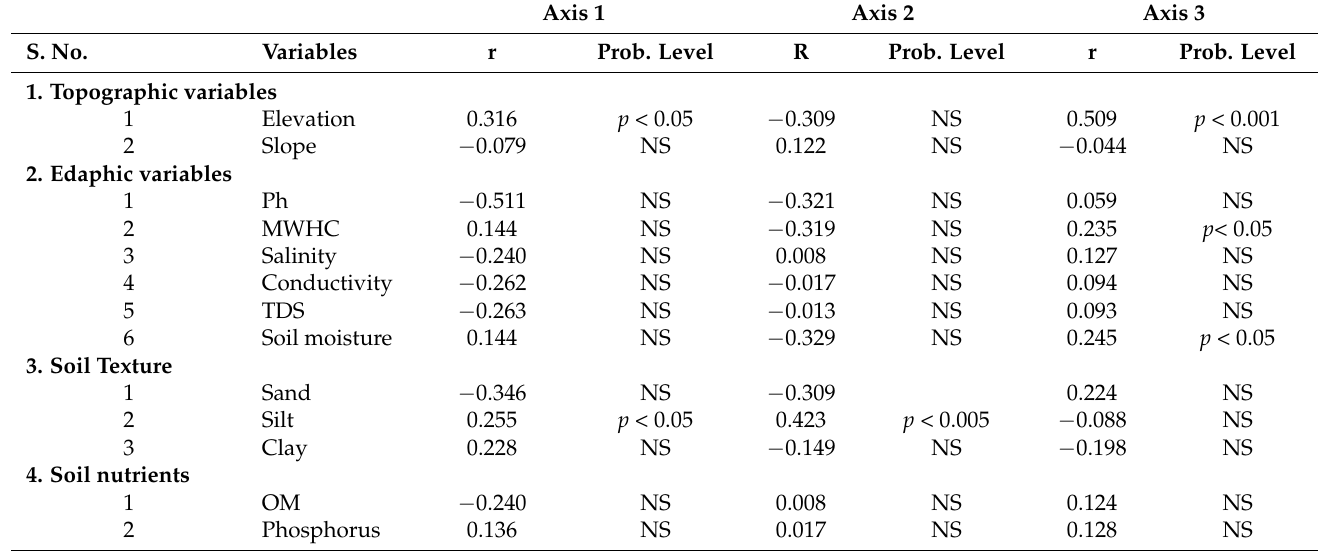
Table 4. The correlation coefficients of environmental variables (topographic variables, edaphic variables, soil texture, and soil nutrients) with 3 PCA ordination axes obtained by tree vegetation data.